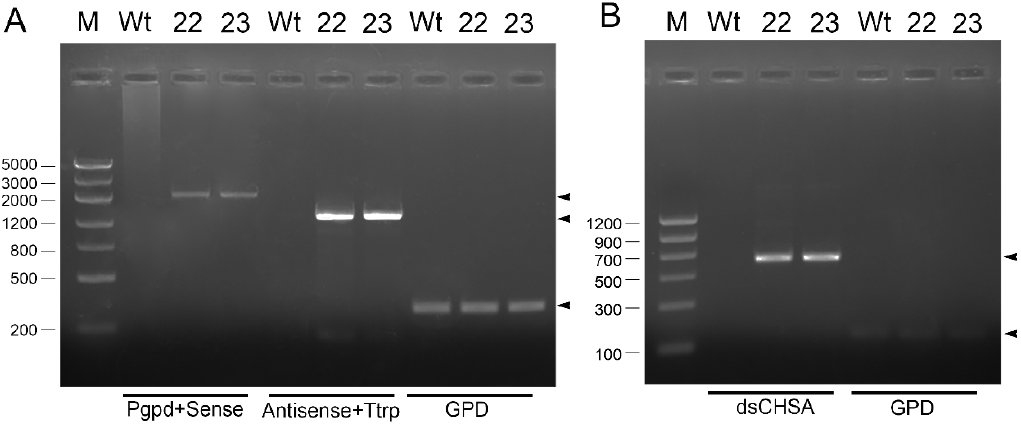
Figure 1. Confirmation of the two transformants of Metarhizium anisopliae . ( A ) Amplification of gpd promoter-CHSA sense-loop and loop-antisense-Trp terminator from genomic, respectively, ( B ) Amplification of CHSA sense + loop from cDNA. Lane M, marker VI(A) and marker II(B); Wt, M. anisopliae wild type; 22 and 23, NlCHSA RNAi transformant lines, GPD of M. anisopliae (across intron primer) used as internal reference.